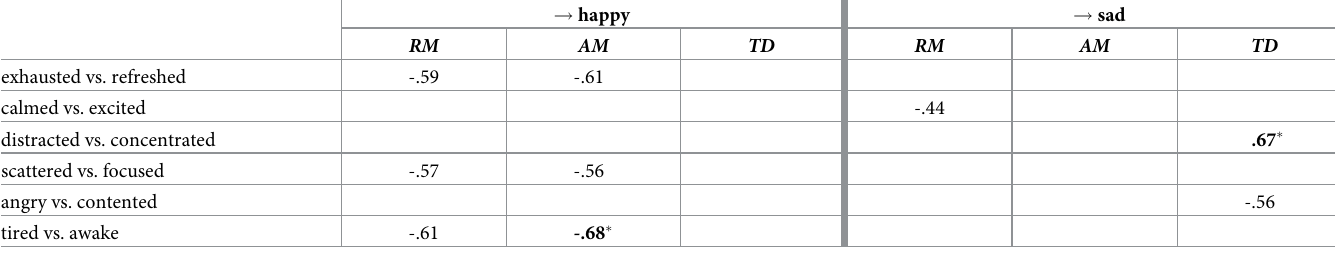
Table 3. Correlation analysis results. Correlation coefficients, across all participant-session combinations for task ‘modulate towards happy’ ( ! happy) and task ‘modu- late towards sad’ ( ! sad), between performance measures (resting mean (RM), action mean (AM), total deviation (TD)) and mood assessment ratings (for the six signifi- cant mood scales of 14 total ratings made by